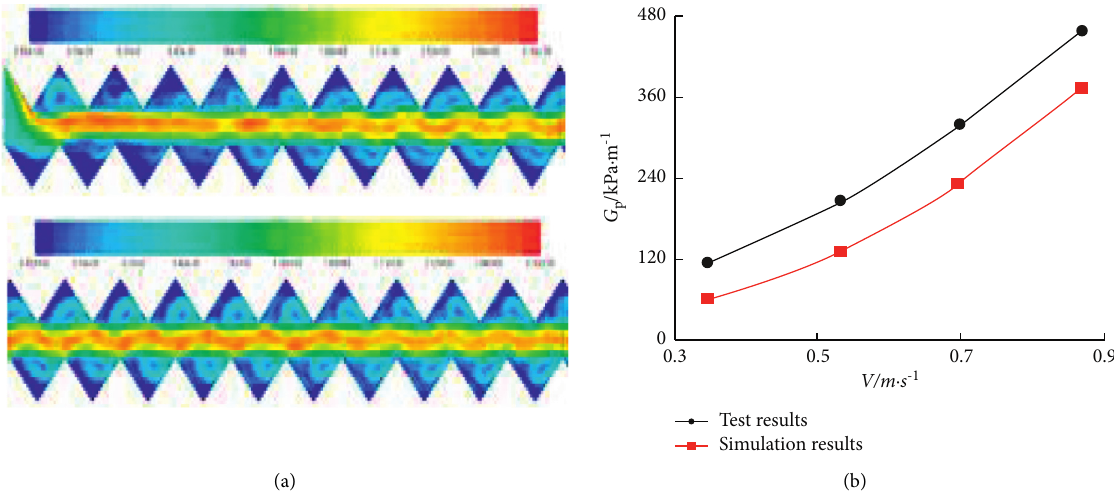
Figure 8: Nephogram of velocity. (a) 0–20 mm and 20–40mm start of fracture. (b) Comparison of curves of G